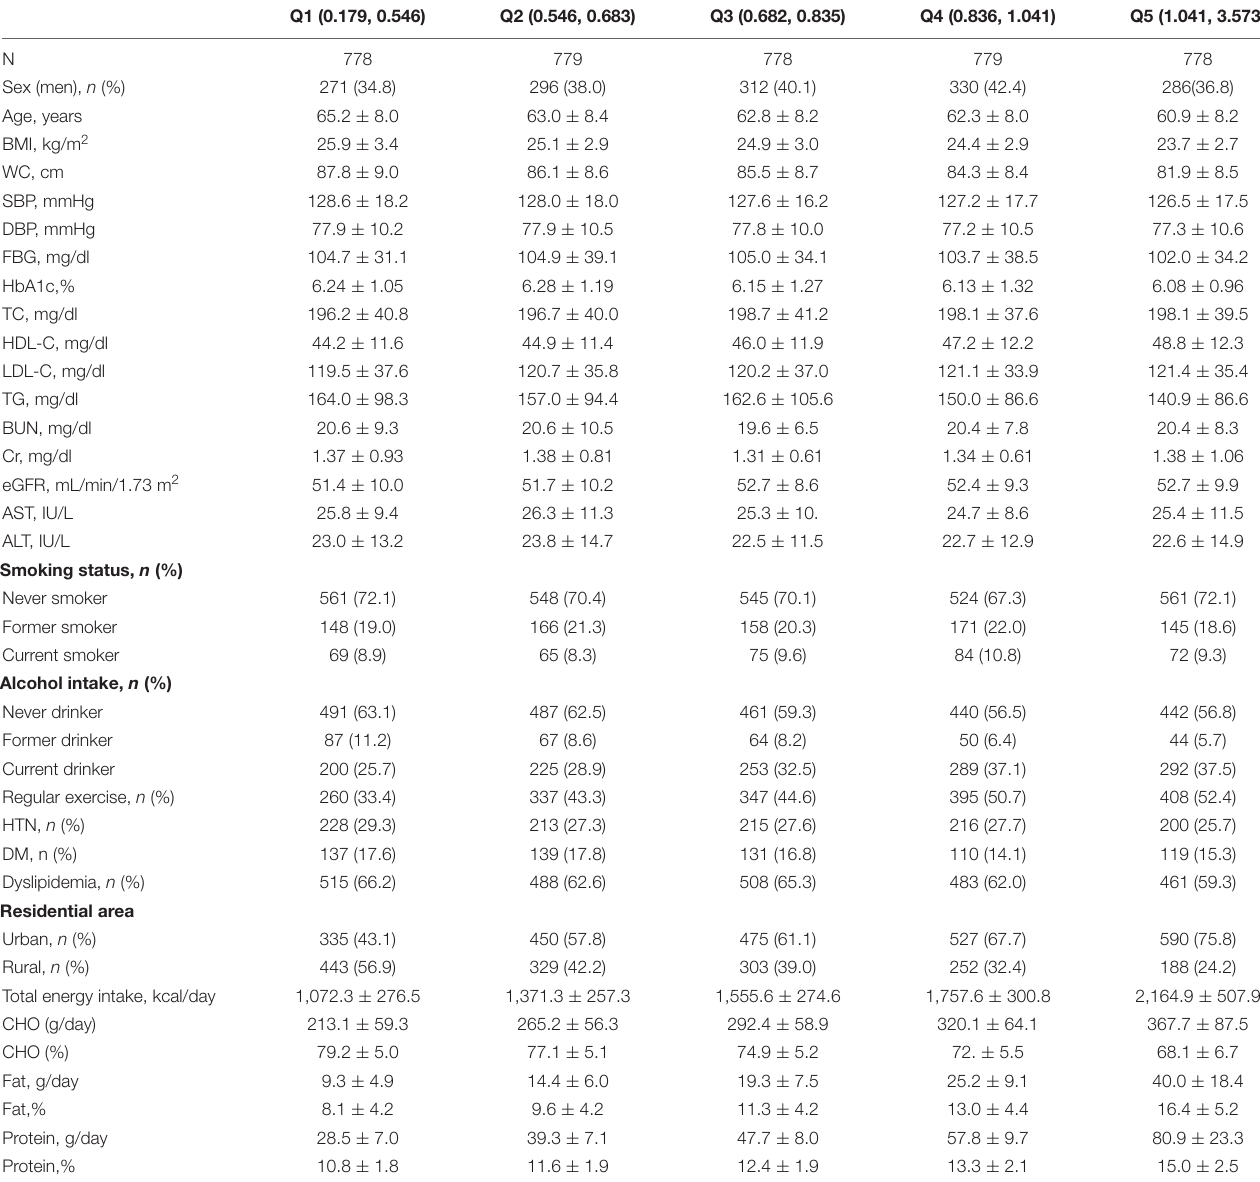
TABLE 1 | Baseline characteristics of the cohort according to protein intake